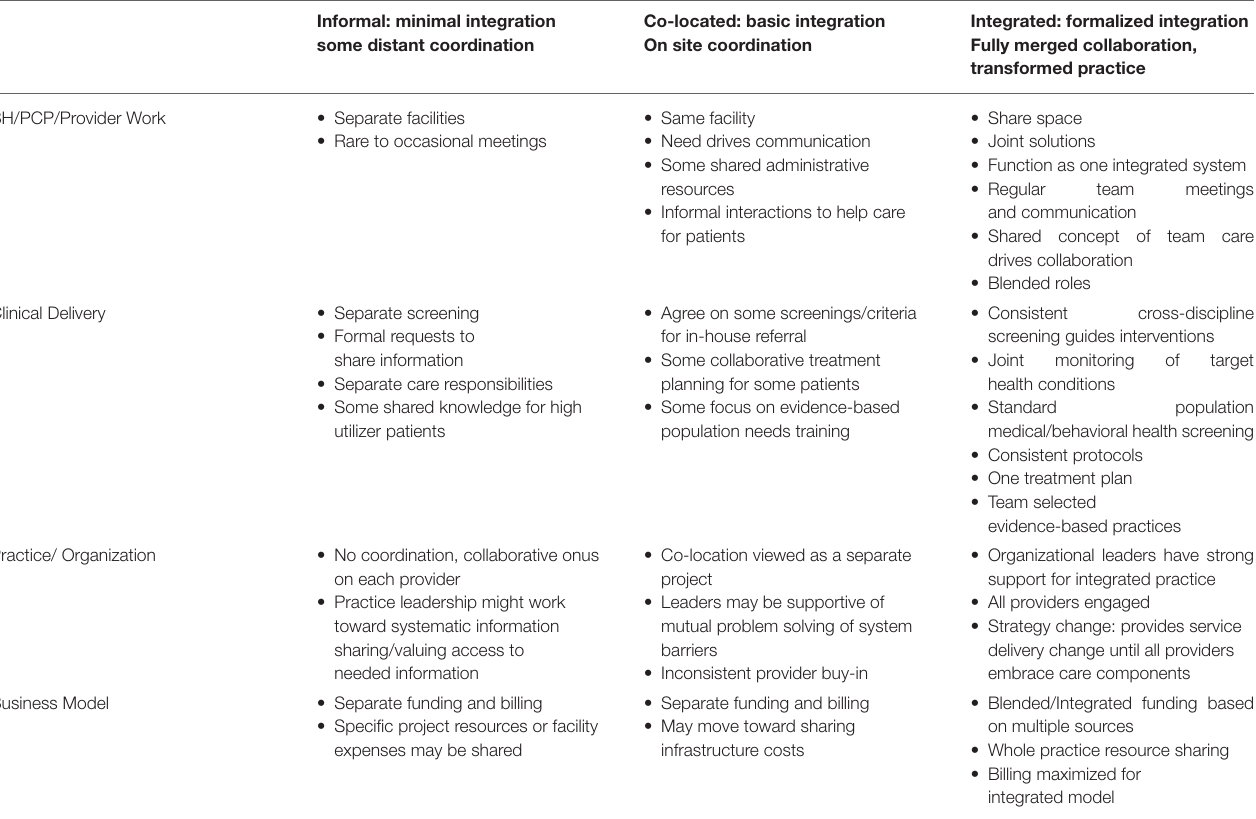
TABLE 1 | Levels of integrated healthcare